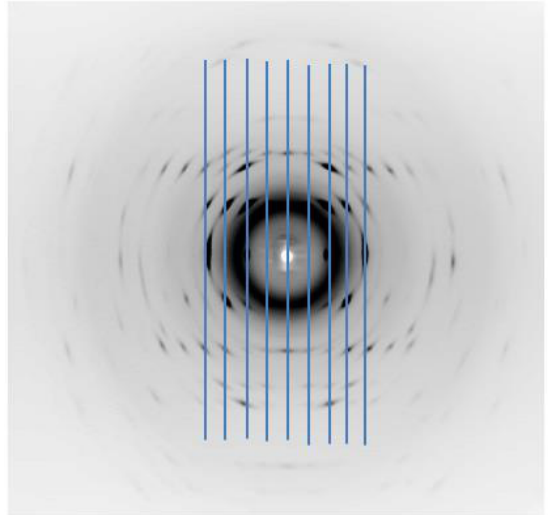
Figure 5. XRD image of the MOMS of α - glycine taken at α = 90 ° with an oscillation angle ϕ between 35 ° and 45 ° .